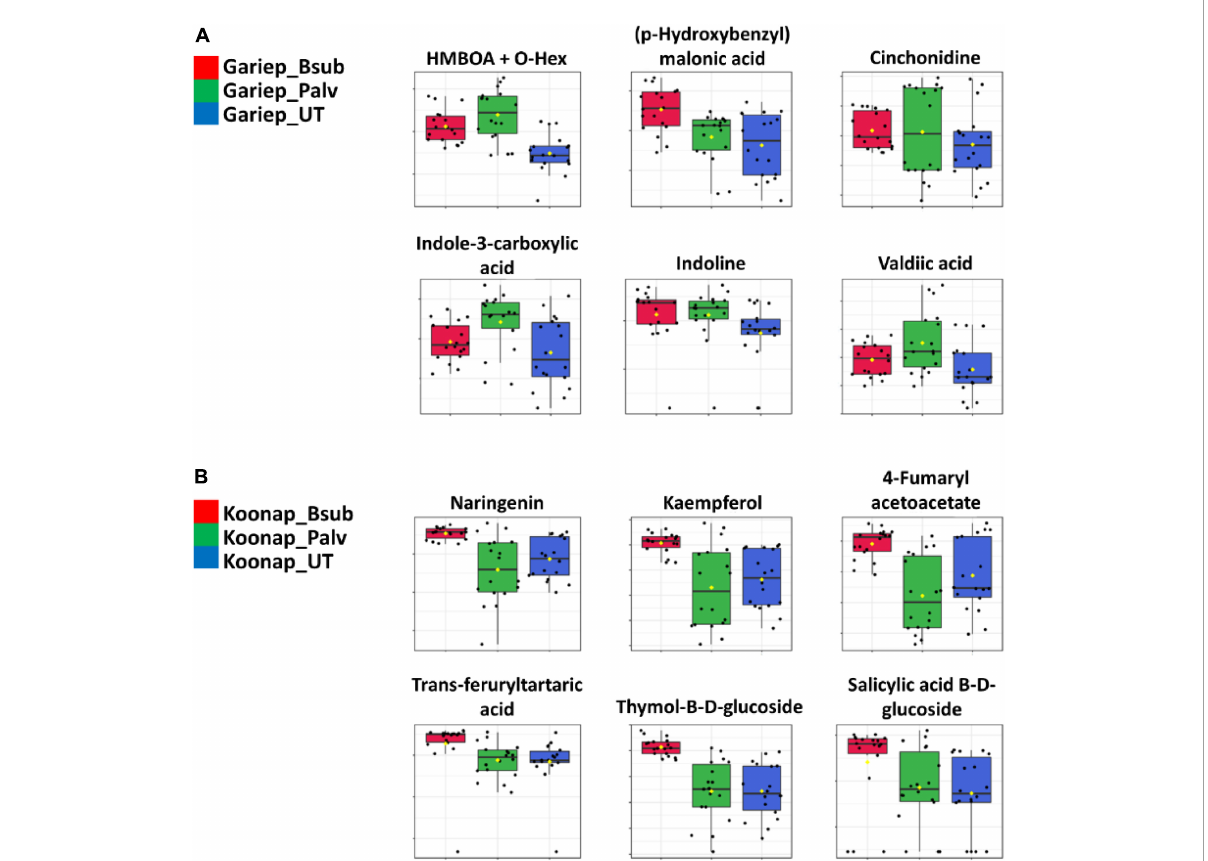
FIGURE5 Differential quantitative profiles of increased annotated metabolites. (A,B) Shows the differential accumulation of selected metabolites in the Gariep and Koonap cultivars respectively. The box-and-whiskers plots reveal an increase in phenolic compounds (phenylpropanoid), organic acids and benzenoids in the rhizospheres of plant growth-promoting rhizobacteria (PGPR)-treated Gariep (A) and Koonap (B) plants. The data were median-normalized, log transformed, and Pareto -scaled. Red and green box-and-whiskers represent B. sub and P. alvei (T22) treatments, blue represents the untreated samples of wheat